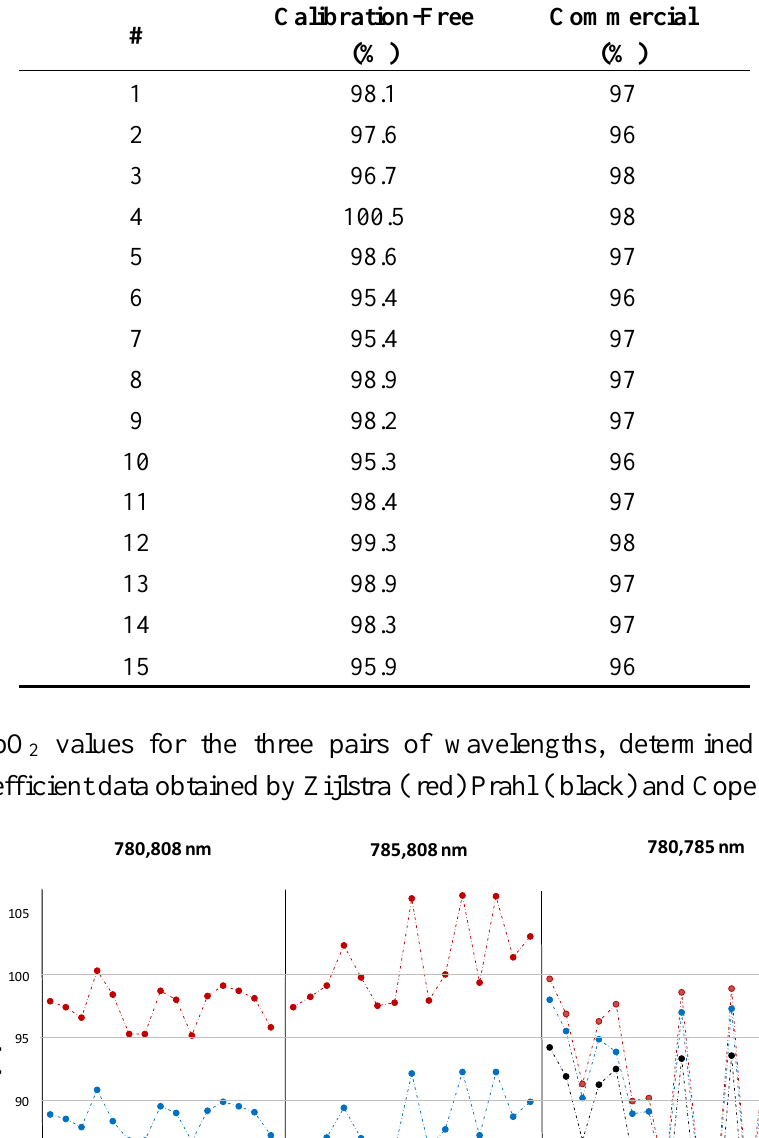
Table 2. SpO values, obtained by the calibration-free pulse oximetry (based on the 2 780–808 nm wavelength pair and on the Zijlstra data) and the commercial pulse oximeter for the 15 healthy subjects.